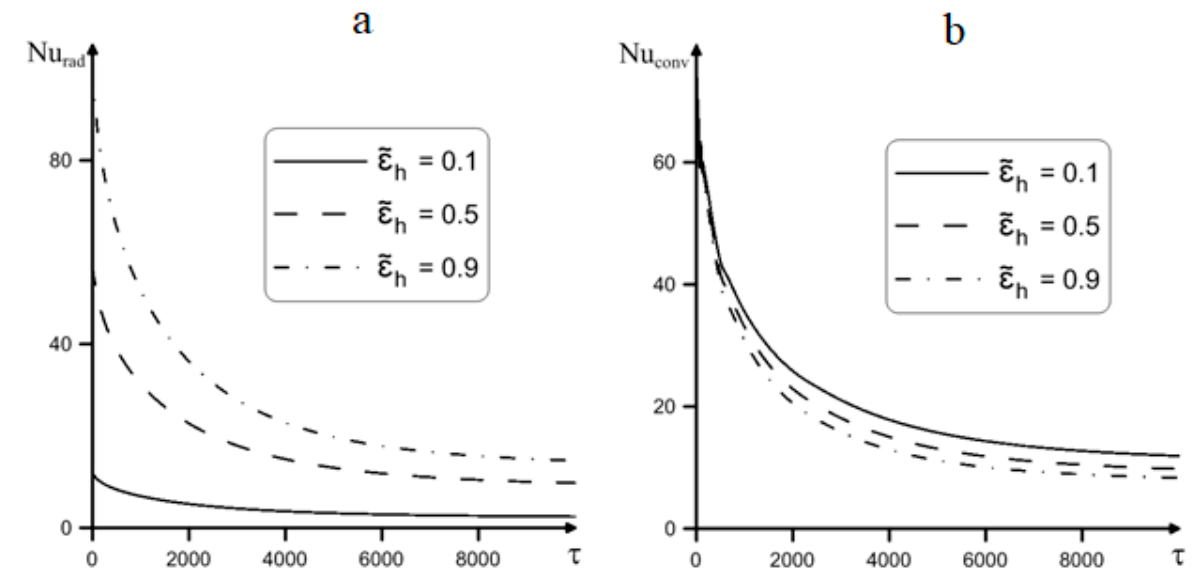
Figure 7. Variations of Nu numbers with time for different surface emissivities of heater: average radiative Nusselt number ( a ) and average convective Nusselt number ( b ).